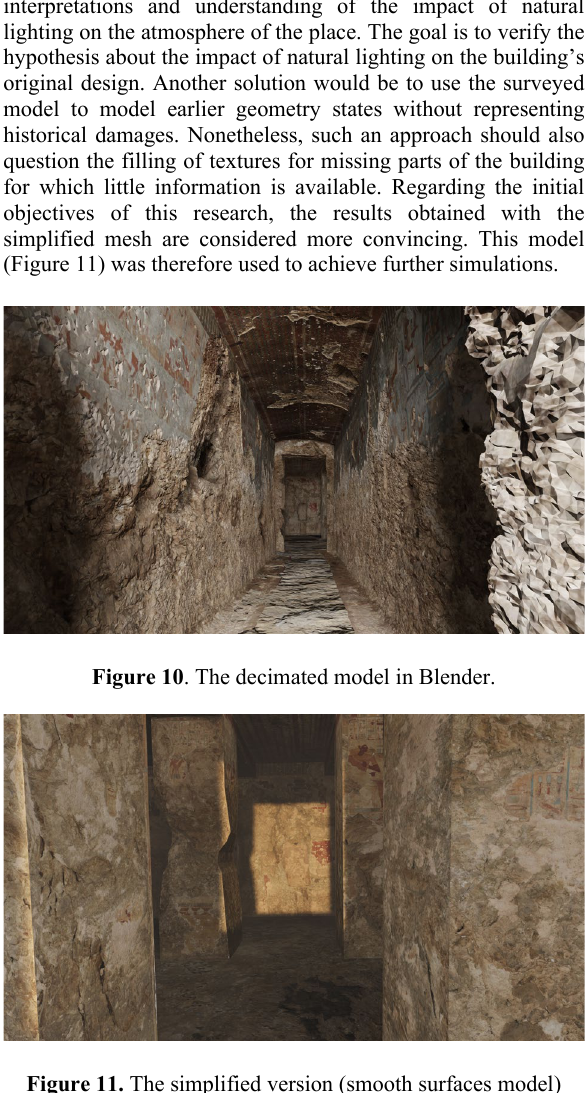
Figure 9 . These images show that the sunrise in Luxor on December 5 occurred at 5:20 in 1500 BC (left), and at 5:05 am at the same date in 2019.